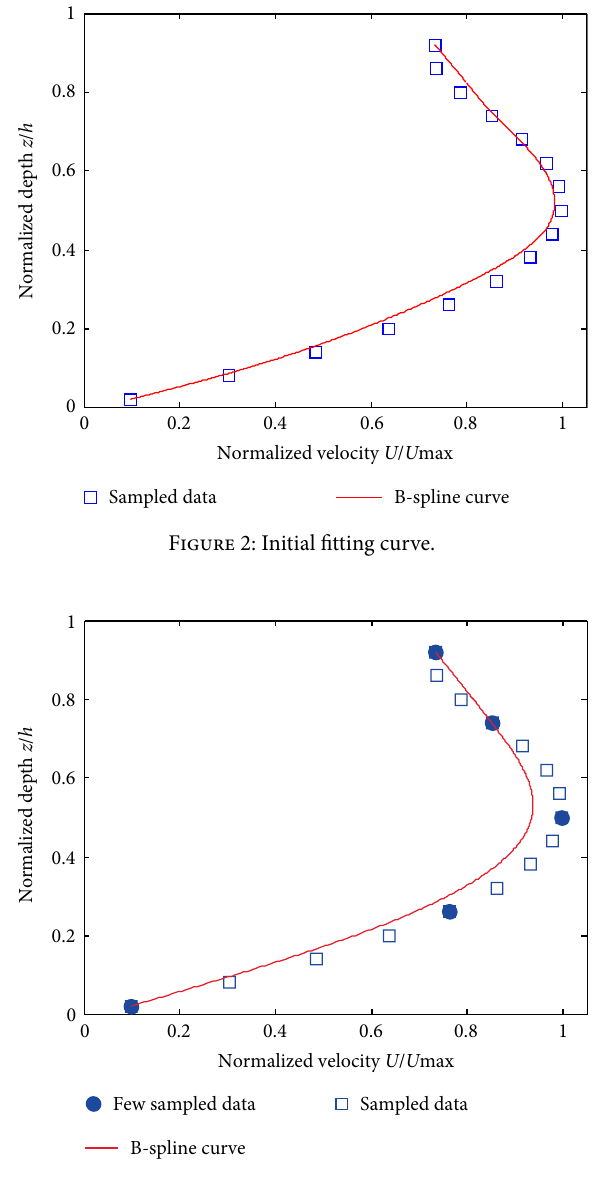
Figure 3: Few sampled data fitting